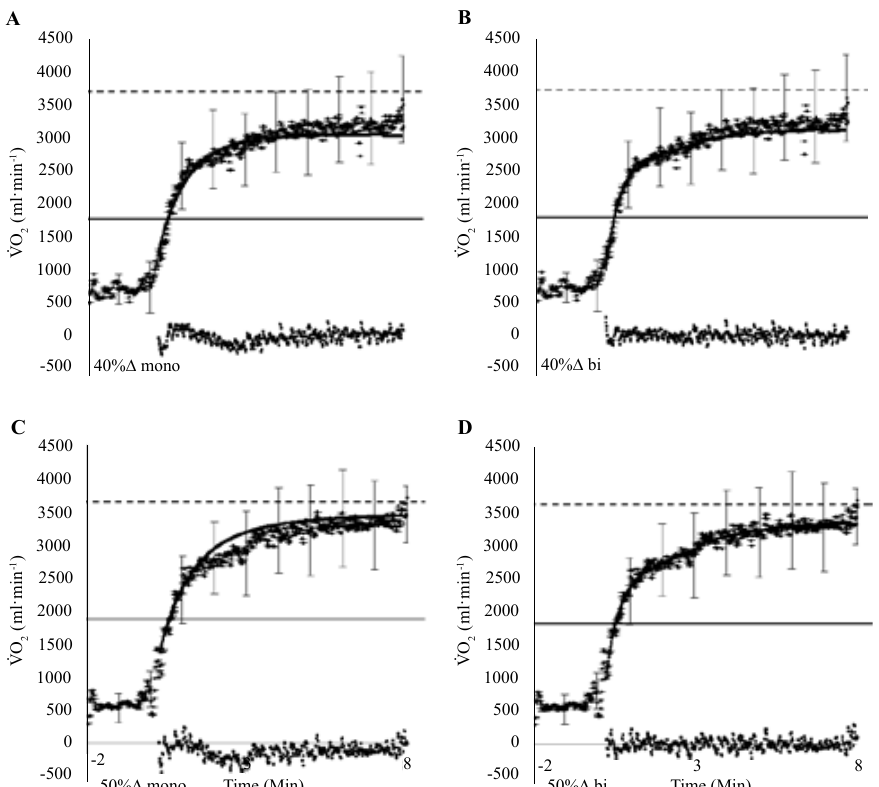
Figure 4. The breath-by-breath oxygen uptake response, mono and bi exponential model fits and residuals across exercise intensity domains in one typical participant. Data from the exercise performed at +40%∆ and +50%∆ are displayed. The V̇ O